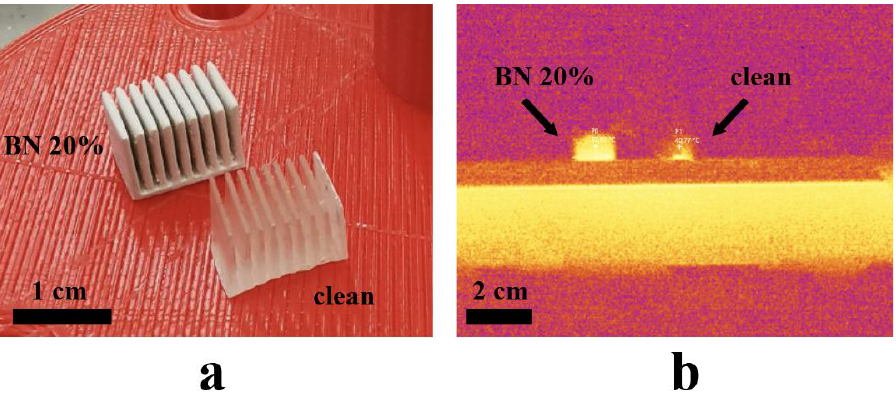
Figure 6. ( a ) Printed samples with and without BN, and ( b ) heat map of the heating process of the two samples. two